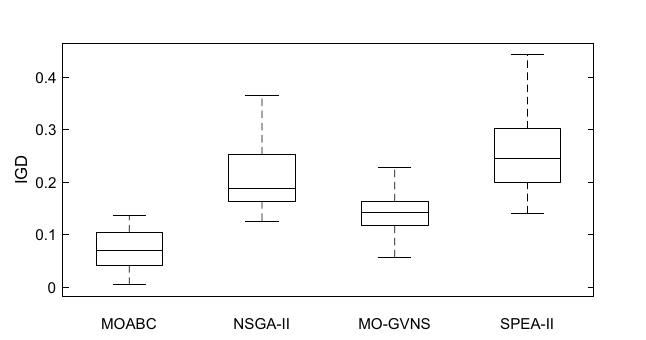
Figure 16. The box plot of IGD.